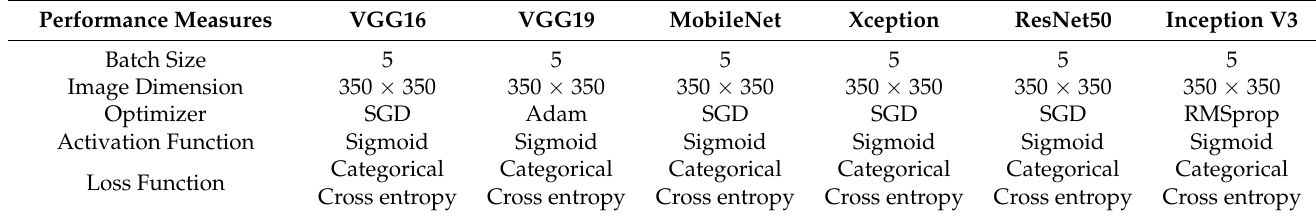
Table 2. Parameters of CNN based pre-trained transfer-learning Models.